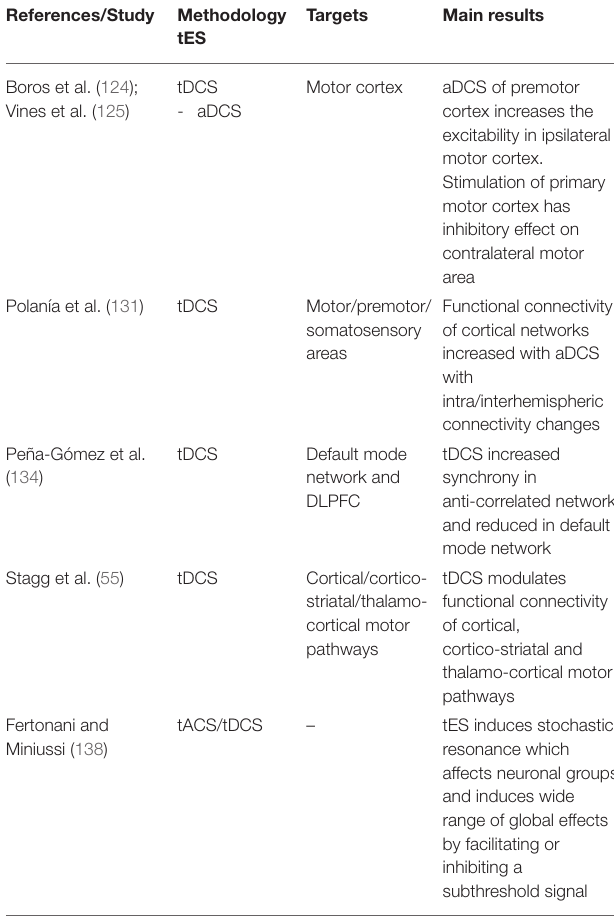
TABLE 4 | tES after-effects on neuronal networks and